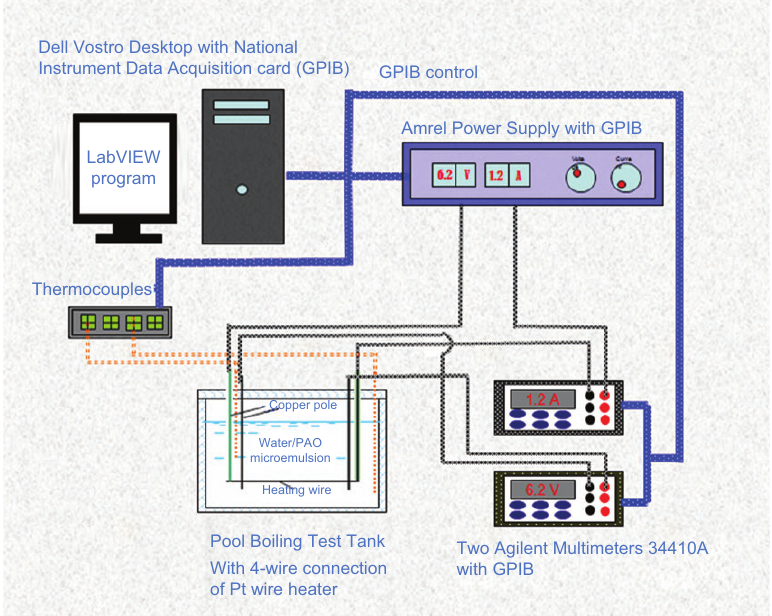
Figure 6 The pool boiling experiment